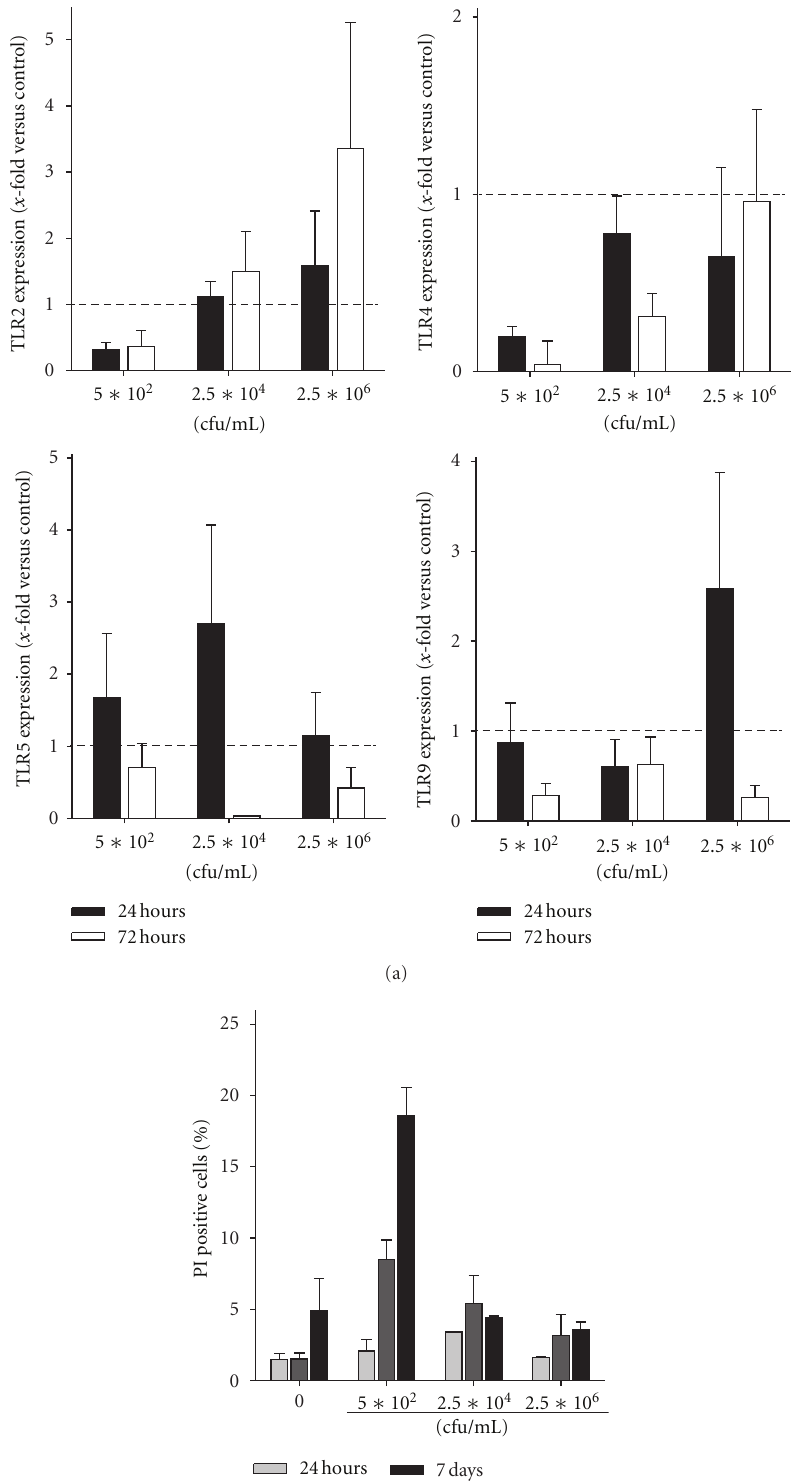
Figure 4: Gene expression analysis and viability of huPBLs. mRNA expression of (a) TLRs in huPBLs following 24 and 72 hours stimulation with CT. Quantitative real-time PCR was performed using predesigned TaqMan gene expression assays. Results show data of three separate experiments each performed in duplicates. (b) Viability of huPBLs as determined by flow cytometric PI staining. Prior to analysis, huPBLs were stimulated with increasing doses of CT and cultured for 24hours, 72 hours, and 7days. Results show data from four di ff erent healthy donors. Values are given as the mean ±